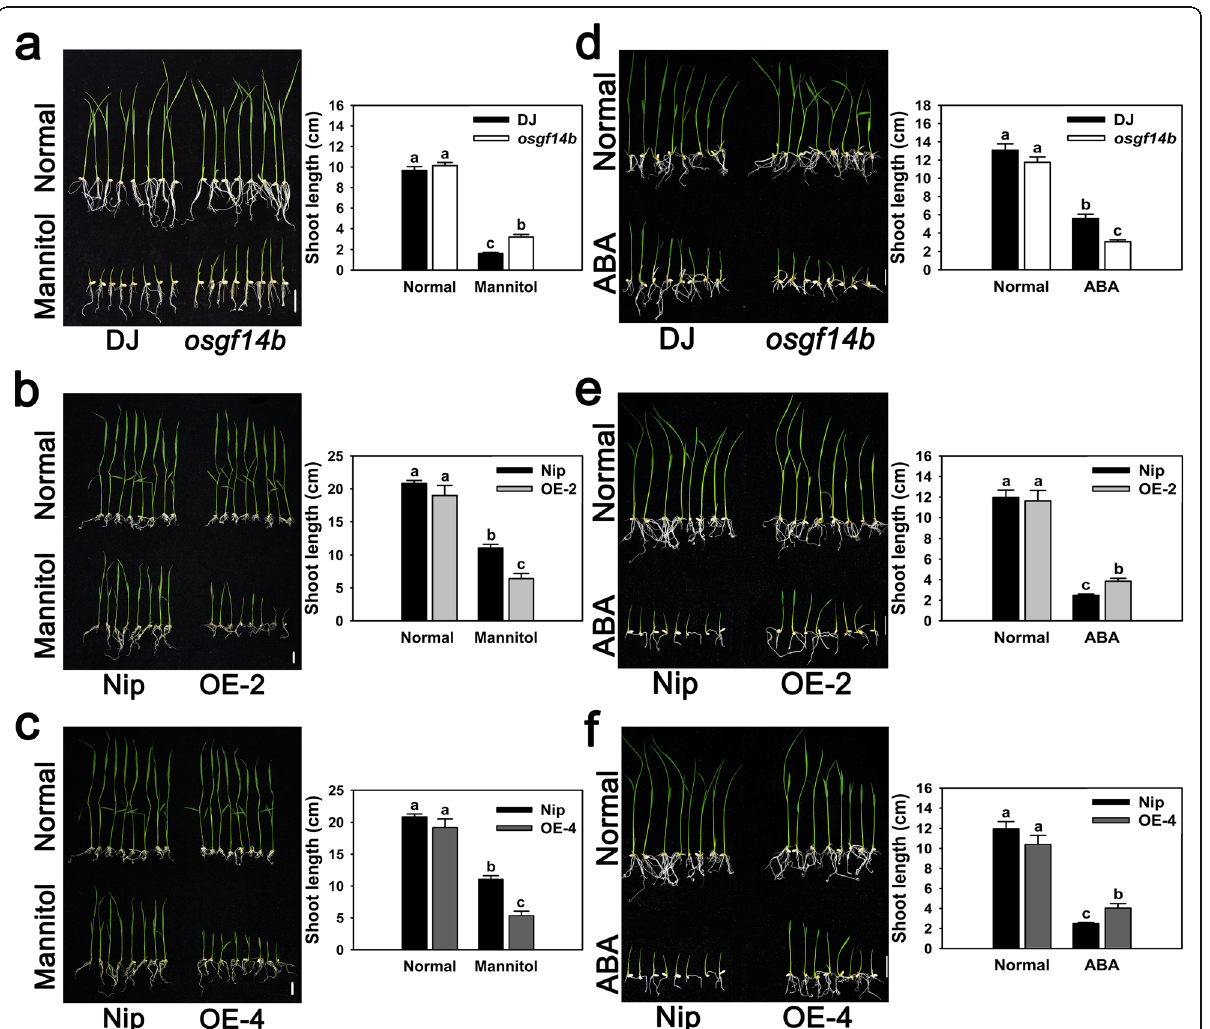
Fig. 2 Osmotic resistance and ABA sensitivity assay of the osgf14b mutant and the OsGF14b -OE lines. a-c The mutant and OE lines were treated with 200 mM mannitol, under normal conditions (no addition of mannitol) as control. d-f The mutant and OE lines were treated with 5 μ M ABA, under normal conditions (no addition of ABA) as control. Shoot length was measured to estimate the resistance and sensitivity of the WT, osgf14b and OsGF14b -OE lines. Error bars represent the SE of three biological replicates. Statistical differences are labeled with different letters according to the LSD test ( P < 0.05, one-way